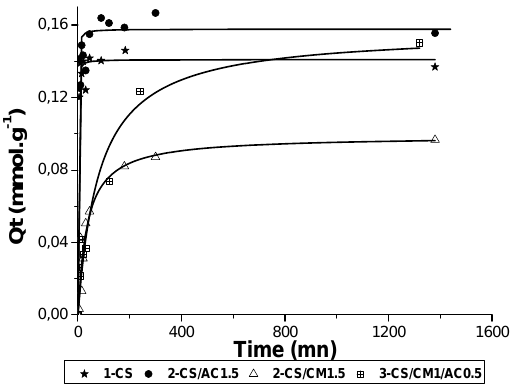
Figure 6. Zn 2+ adsorption kinetics on pure and hybrid hydrogel CS beads. The continuous lines represent the calculated data using the first-order model. represent the calculated data using the first-order